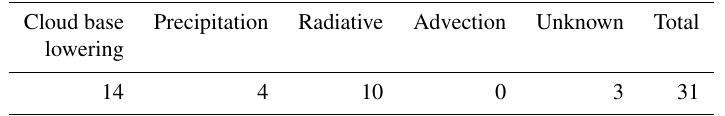
Table 3. Number of fog types observed at the SIRTA observation site between 1 November 2018 and 19 February 2019.